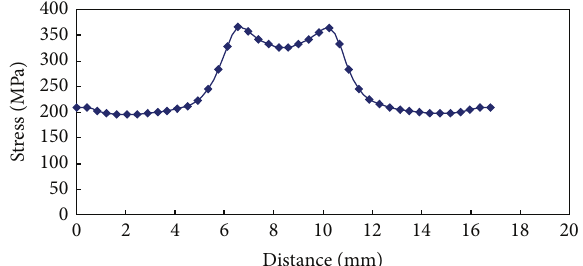
Figure 7: The stress of node on the intersecting lines between 𝑋 - 𝑍 plane and cavity, 𝐿/𝑅 =